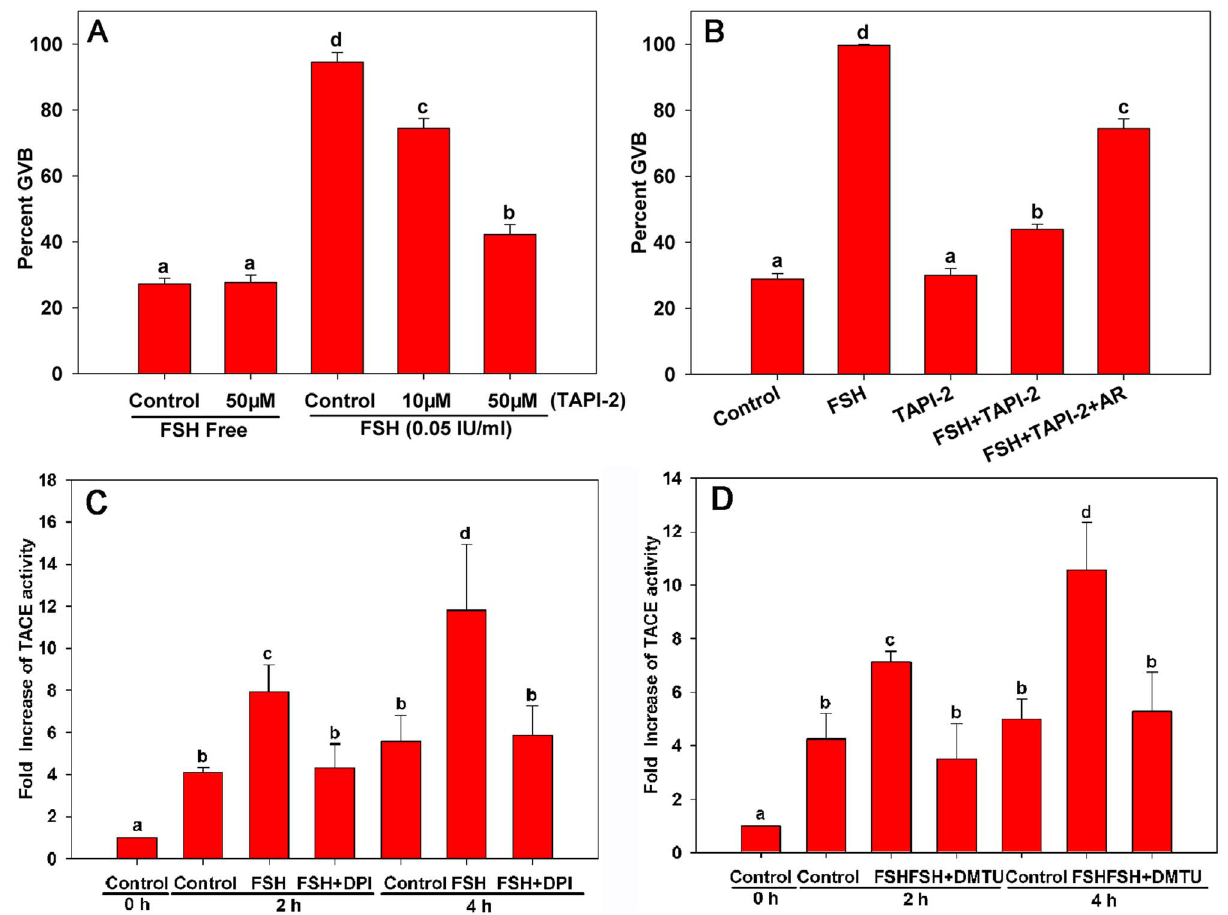
Figure 3. The effect of NOX and its ROS products on TACE activity during FSH-induced meiotic resumption in mouse COCs. COCs were cultured respectively in the following media: ( A ) FSH-supplemented media with or without TACE selective inhibitor TAPI-2 for 22–24 h; ( B ) media supplemented with 50 m M TAPI-2, 0.05 IU/mL FSH, TAPI-2 plus FSH, or TAPI-2 plus FSH plus 100 ng/mL Areg for 22–24 h. Figures C and D indicate the TACE activity in cumulus cells of COCs cultured in FSH-supplemented media with or without NOX inhibitor diphenyleneiodonium chloride (DPI, 30 nM), ROS scavenger 1,3-dimethyl-2-thiourea (DMTU, 30 mM) for 0, 2 or 4 h. Letters (a–d) on different columns in each chart indicate a significant difference between groups ( p , 0.05). AR: